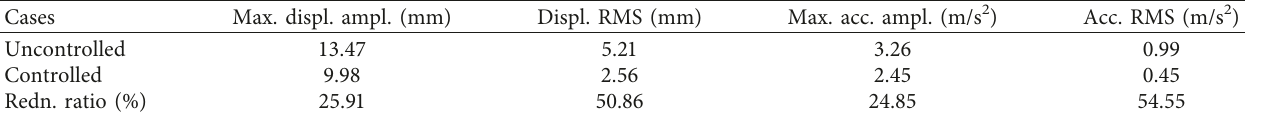
Table 7: Dynamic responses of the main structure under El Centro